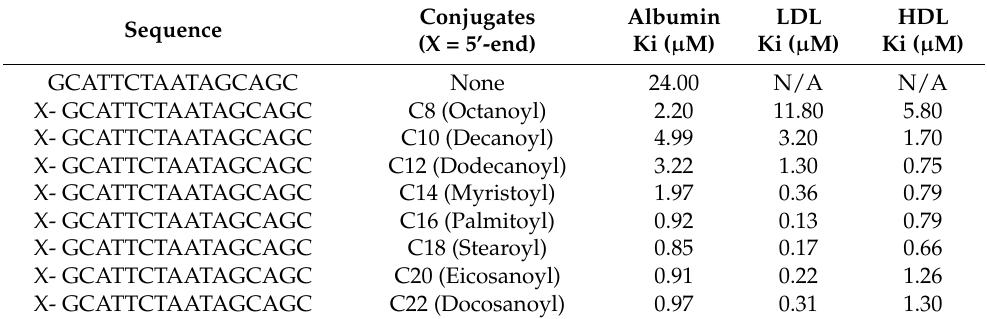
Table 4. Adapted protein binding data from Prakash et al. displayed the trends depending on carbon